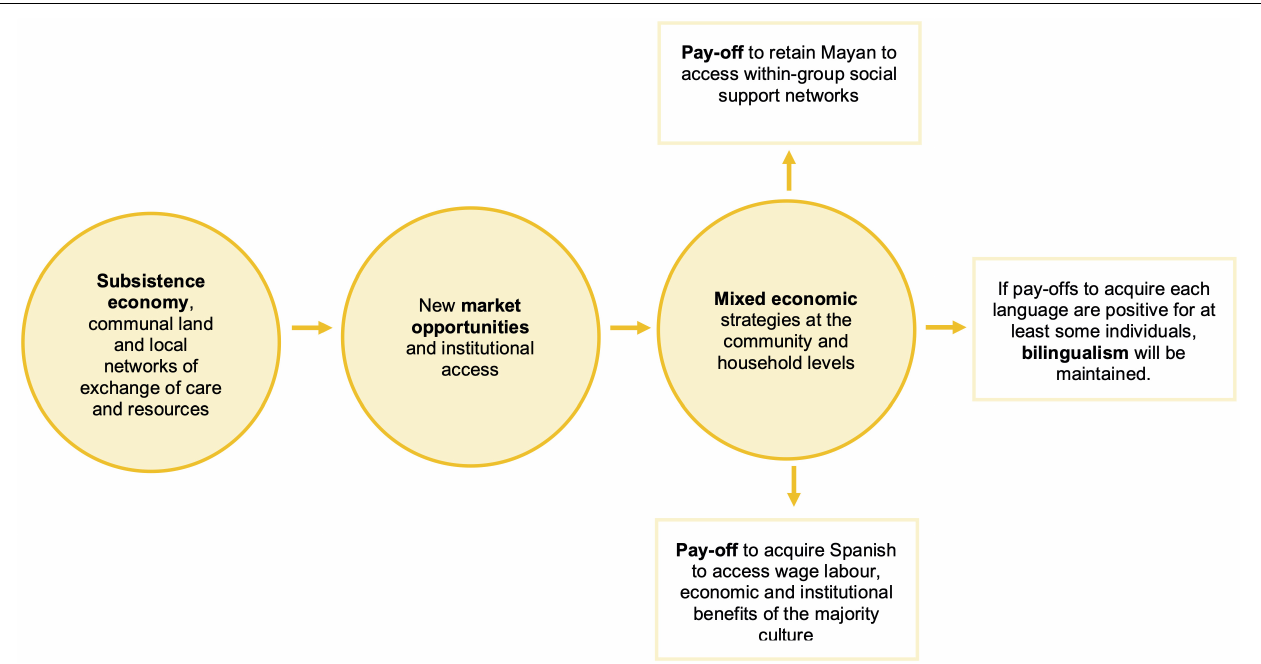
FIGURE 7 | A schematic representation of the processes linking changes associated with market integration with economic and social influences on the payoffs to different linguistic repertoires. Payoffs predict those circumstances under which indigenous language use would be sustained and long-term linguistic diversity maintained, and those under which they are at